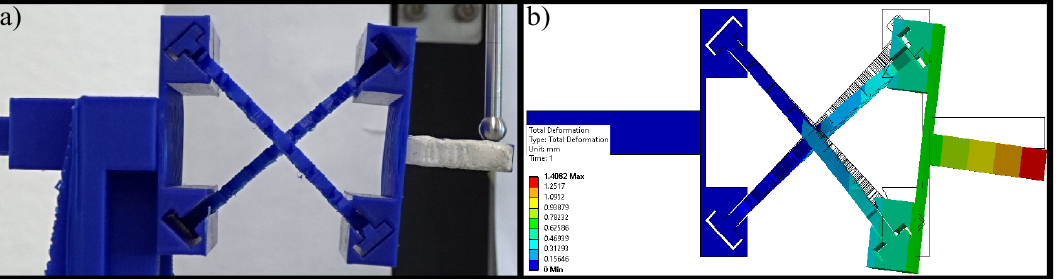
Figure 12. Comparison of a re-entrant compliant cross-axis joint with a unit cell of 5.5 mm at 60° orientation. ( a ) The first mechanical test run on the re-entrant compliant cross-axis joint. ( b ) Compliant cross-axis joint with deformed shapes obtained with Ansys Workbench ® . The color map scheme represents